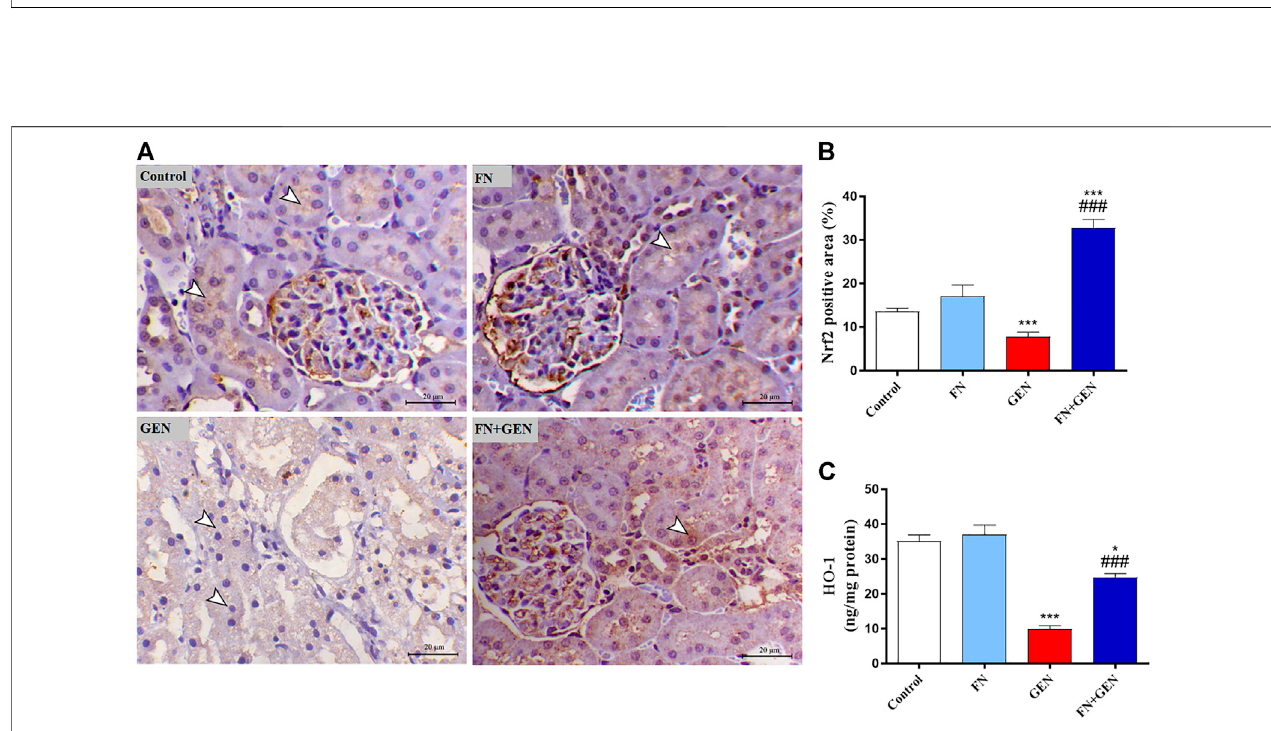
FIGURE 9 | FN increases renal Nrf2/HO-1 in GEN-intoxicated animals. (A) Photomicrographs of renal sections from control and FN-treated rats demonstrating marked expression of Nrf2 in the tubular epithelia (arrowheads), GEN-administered animals showing decreased immunostaining of Nrf2 within the epithelial cells ’ renal tubules(arrowheads),andGEN-intoxicatedratspre-treatedwithFNdemonstratingmarkedincreaseintheexpressionofNrf2antibodywithintherenaltubularepithelium (arrowheads) (IHC, X200, scale bar = 20 µm). (B) Image analysis of Nrf2 immunostaining demonstrating signi fi cant upregulation in the kidney of GEN-intoxicated rats treatedwithFN. (C) FNincreasedHO-1 expression inthe kidneyofGEN-intoxicatedrats. Results aremean ±SEM( n =6). p indicates p < 0.05, and ppp indicates p < 0.001 versus control, while ### indicates p < 0.001 versus GEN. FN: formononetin; GEN: gentamicin; and Nrf2: nuclear factor-erythroid factor 2-related factor 2.